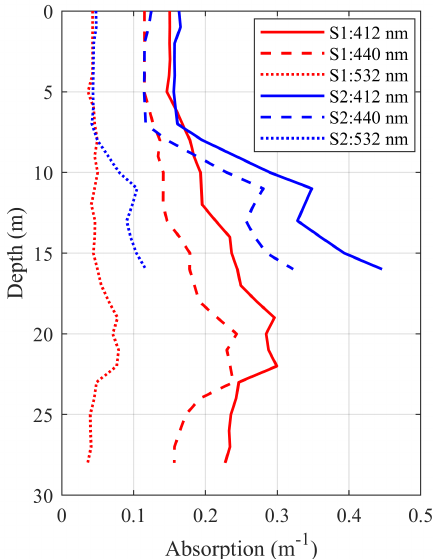
Figure 7. In situ absorption coe ffi cient collected in the Yellow Sea.